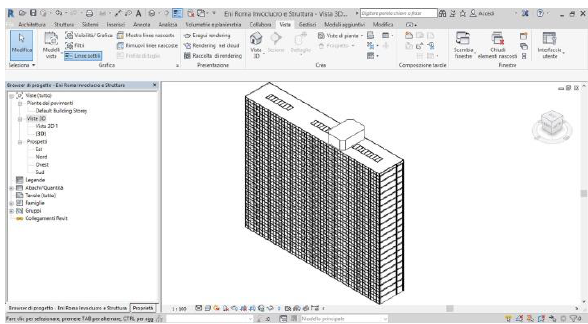
Figure 9: the BIM model of the ENI Office Building in Rome